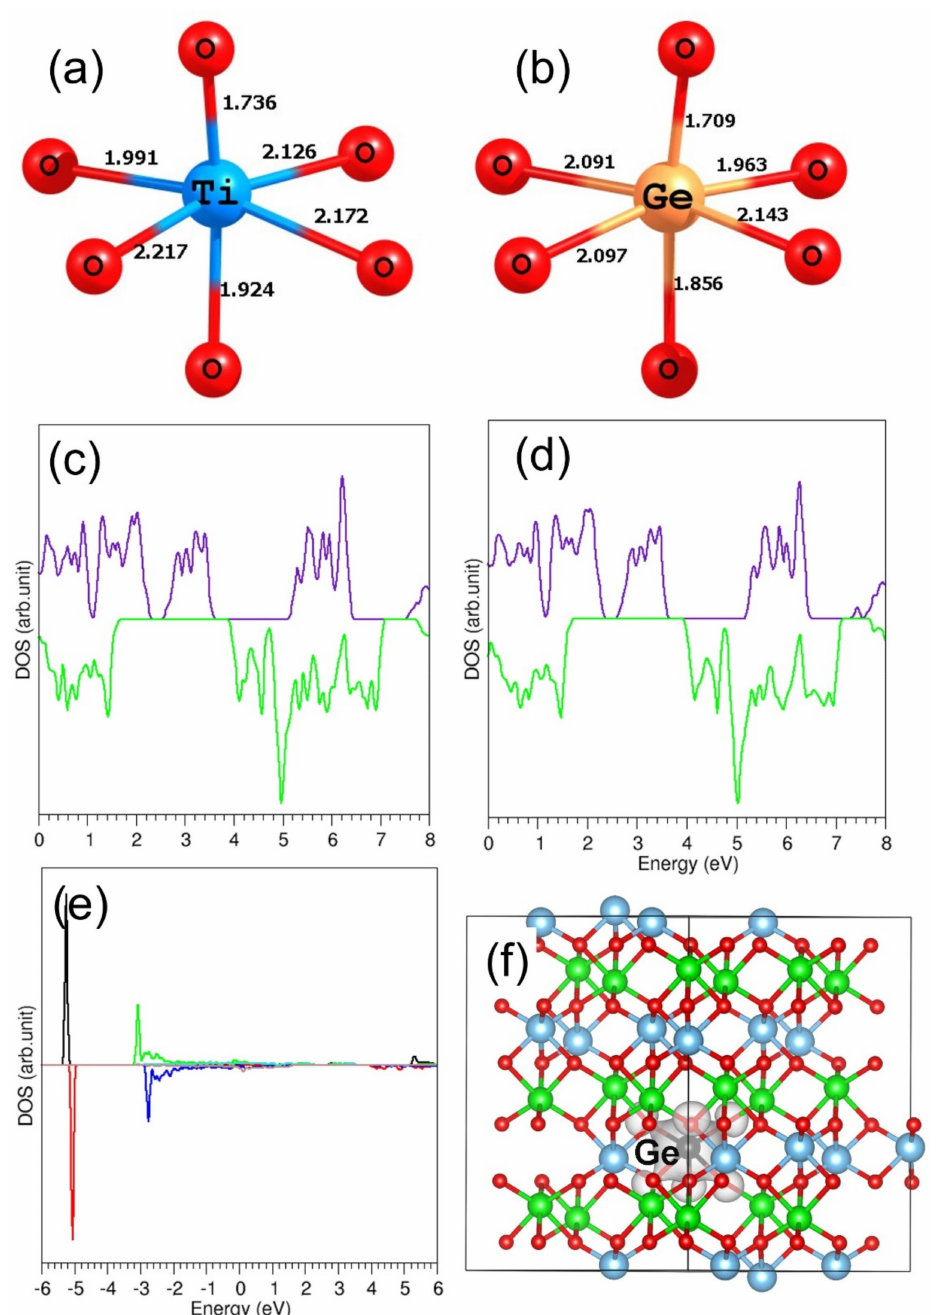
Figure 10. ( a ) TiO 6 octahedral unit showing bond lengths in the relaxed un-doped FeTiO 3 , ( b ) GeO 6 unit in the configuration of Ge 4 + doped at the Ti site, ( c ) total density of states (DOS) of FeTiO 3 , ( d ) total DOS of Ge-doped FeTiO 3 , ( e ) atomic DOS of Ge, and ( f ) charge density plot associated with the deep s states of